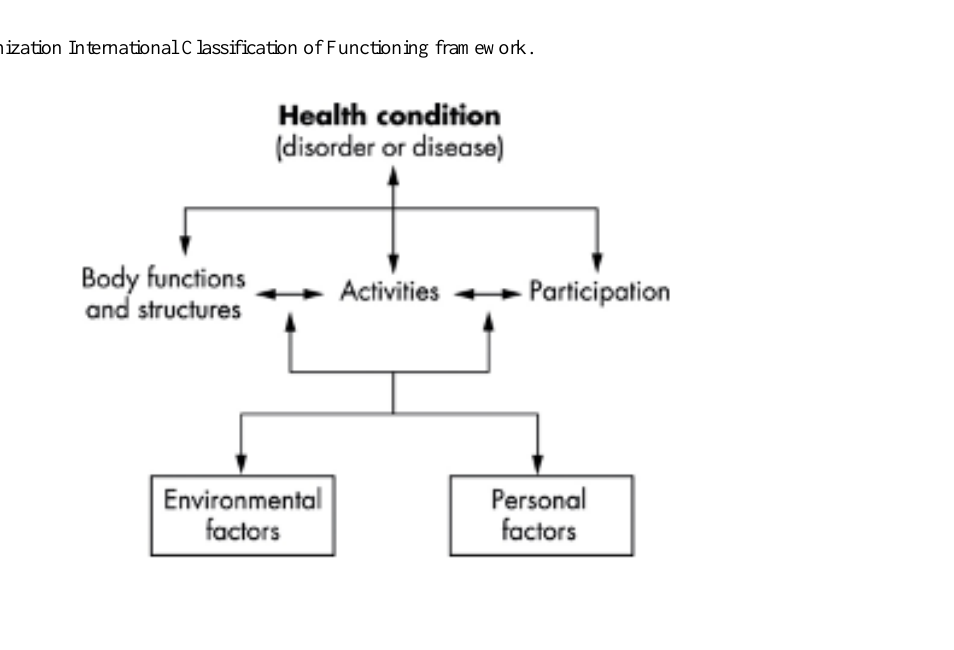
Table 1. People with dementia and informal caregiver well-being profile based on the World Health Organization International Classification of Functioning